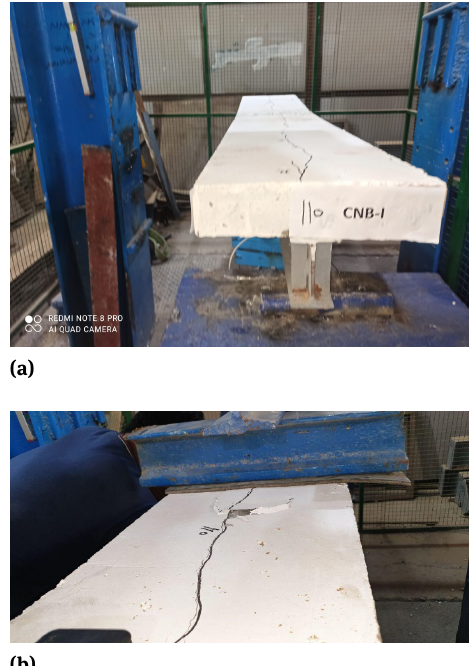
Figure 9: Failure mode of Specimen